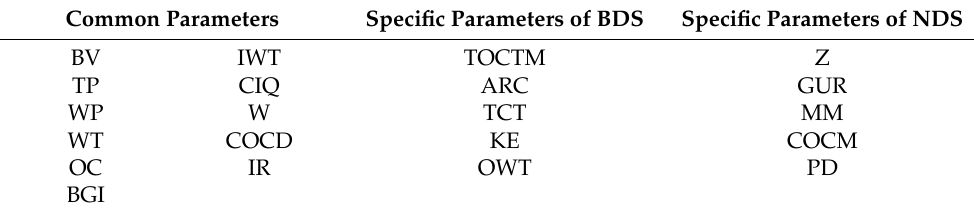
Table 2. Input parameters of the two models.